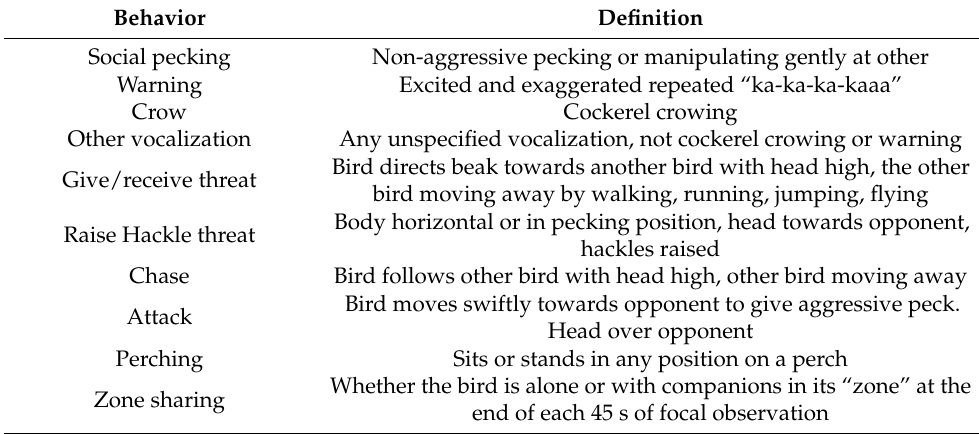
Table 1. The ethogram used in the behavior recordings. Behavior Definition Social pecking Non-aggressive pecking or manipulating gently at other Warning Excited and exaggerated repeated “ka-ka-ka-kaaa” Crow Cockerel crowing Other vocalization Any unspecified vocalization, not cockerel crowing or warning Bird directs beak towards another bird with head high, the other Give/receive threat bird moving away by walking, running, jumping, flying Body horizontal or in pecking position, head towards opponent, Raise Hackle threat hackles raised Chase Bird follows other bird with head high, other bird moving away Bird moves swiftly towards opponent to give aggressive peck. Attack Head over opponent Perching Sits or stands in any position on a perch Zone sharing